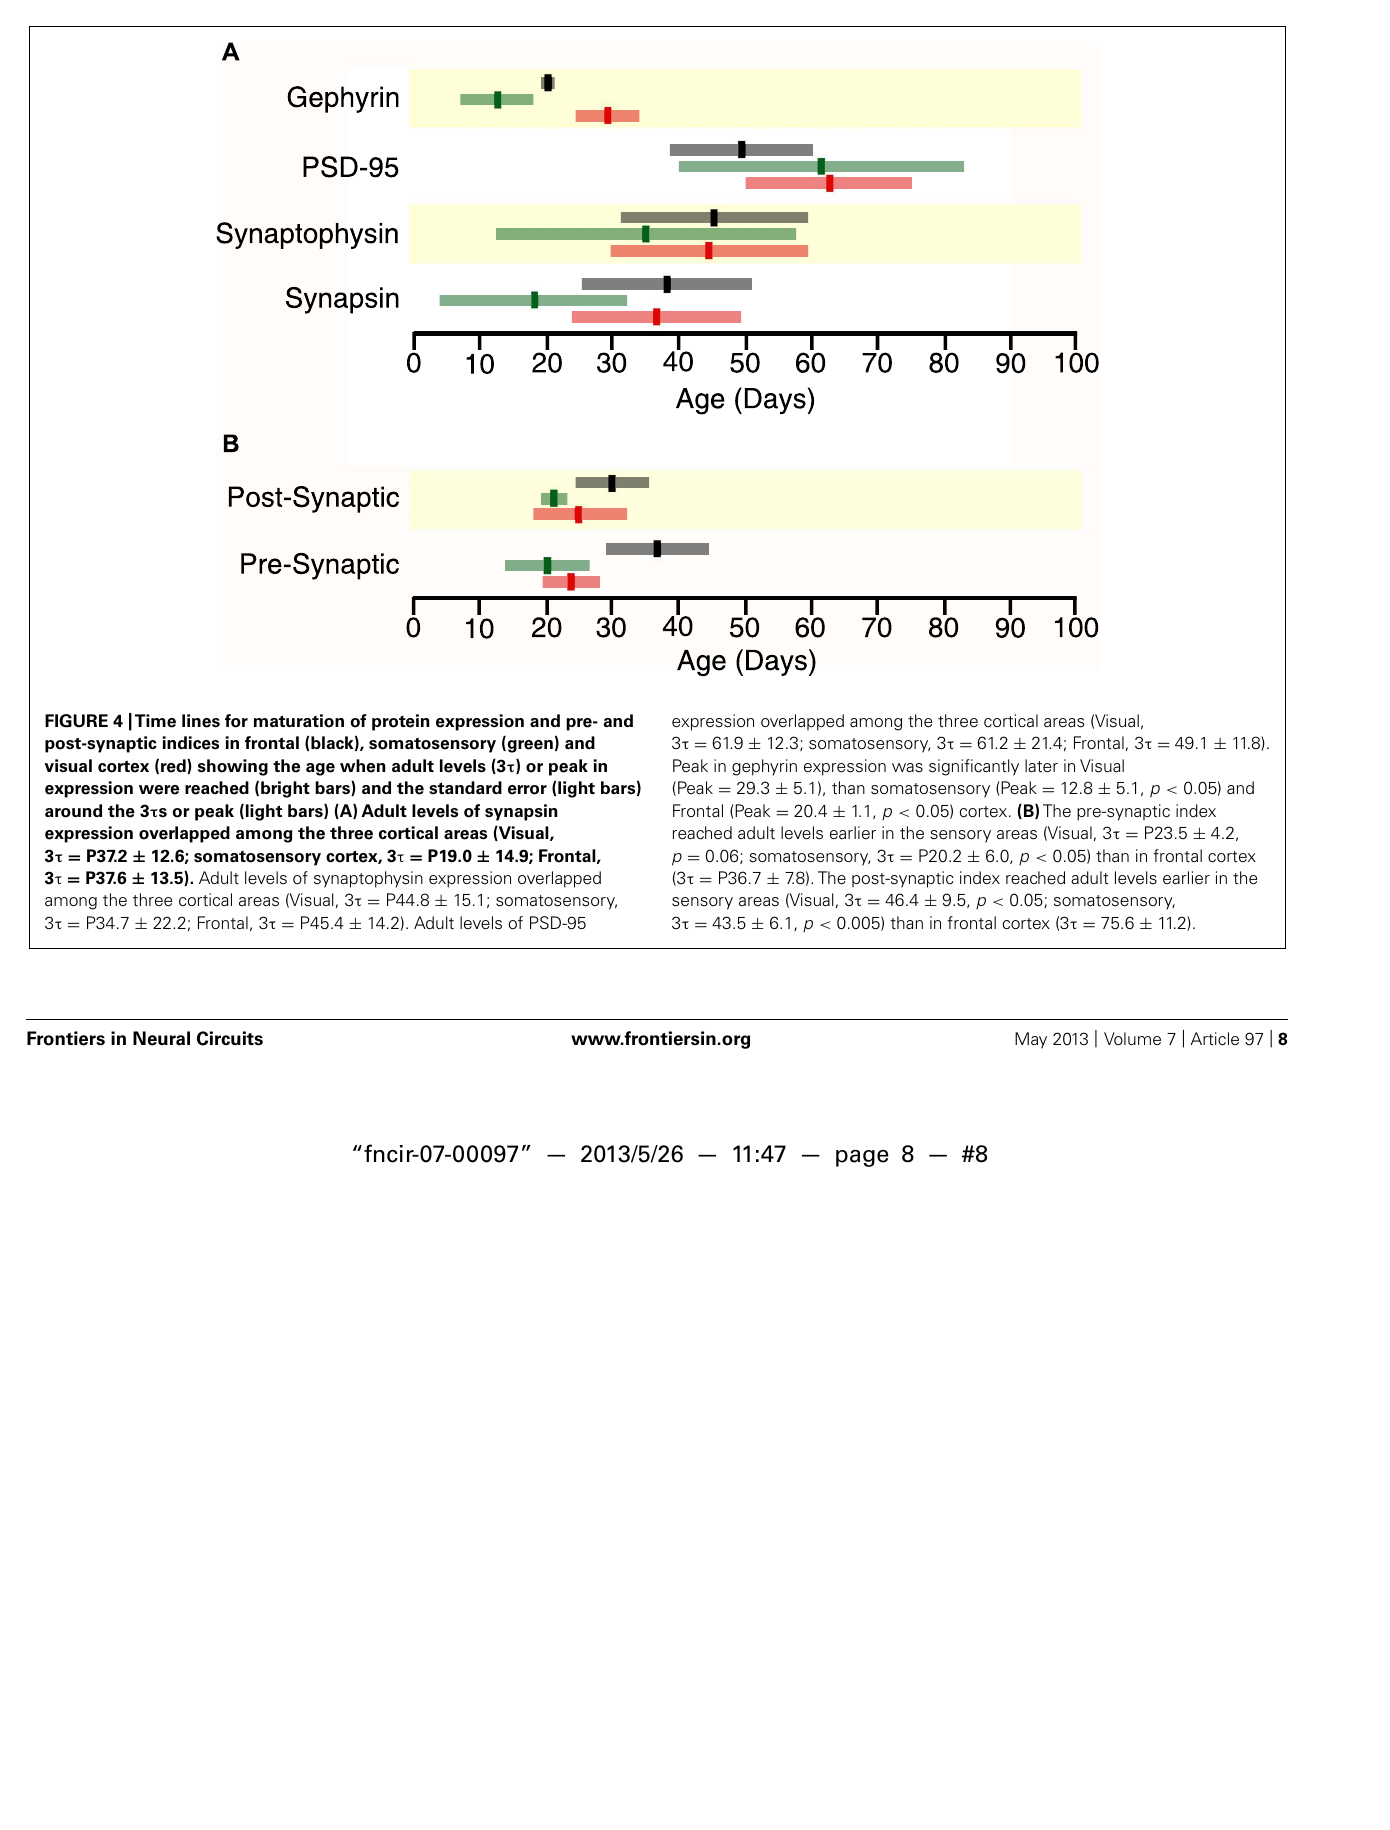
( Figure 3G , curve-fit R = 0.83 p < 0.0001) between P11 and P49 (3 τ = p 49.1 ± 11.8). There were no significant ( z -test) differences